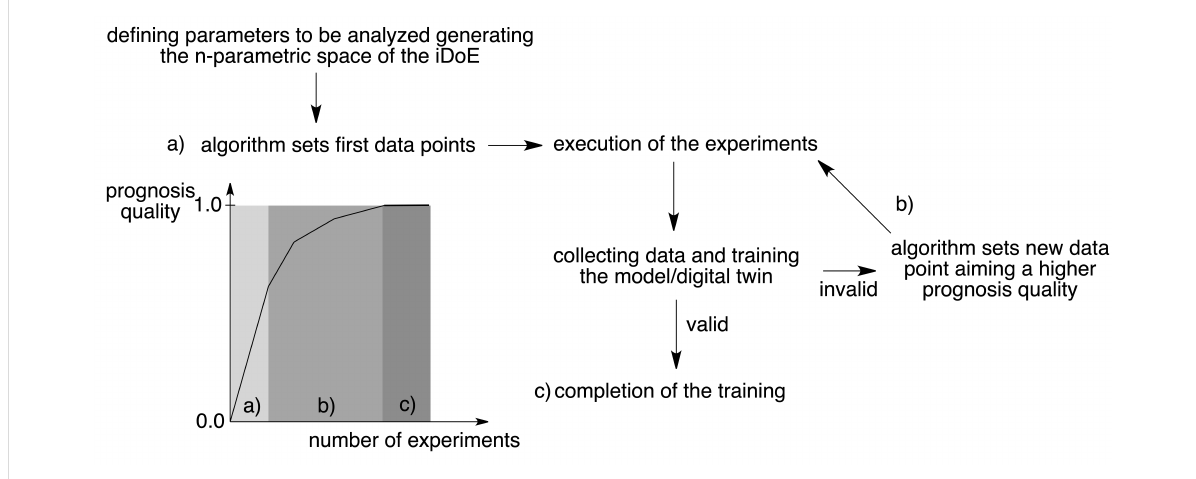
Scheme 14: Illustration of the iDoE setting up experiments suggested and analyzed by the A.I. After defining the space of the iDoE by the scientist the algorithm will suggest the starting points (a) and check the validity of the model. In case of a low prognosis quality the A.I. set new data points in experimental spaces with a lack of information (b) improving the model. The task will be finished if the model is capable to predict the outputs based on the inputs within a desired boundary